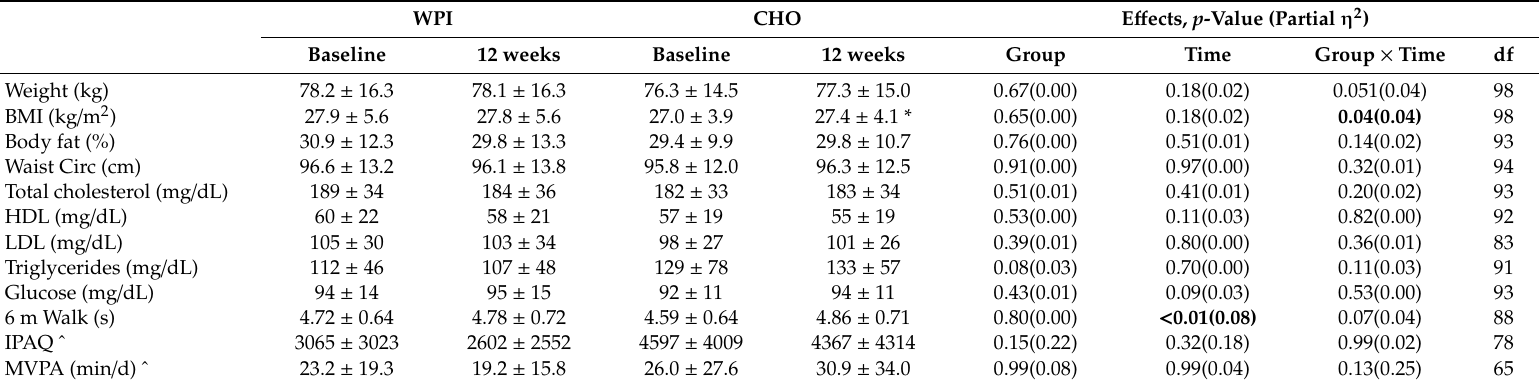
Table 2. Changes in anthropometrics, blood lipids, mobility, and global cognition from baseline to 12 weeks in WPI vs. CHO (mean ± SD).